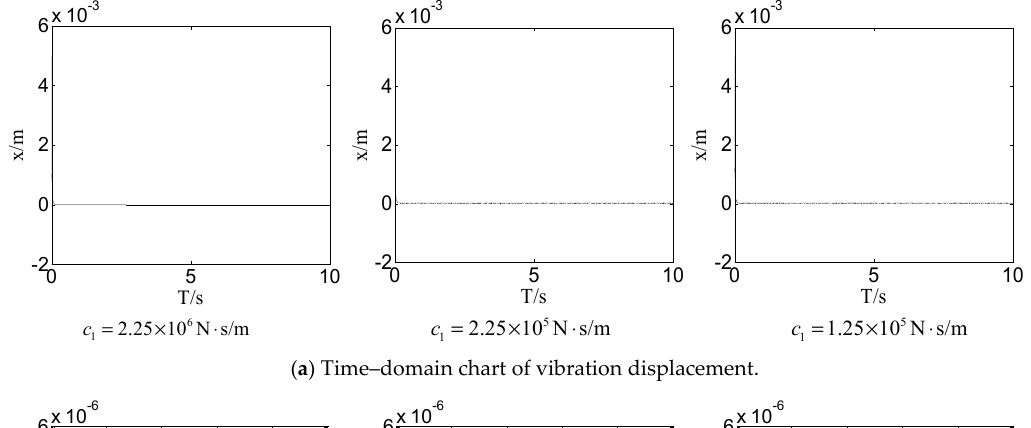
( a ) Time–domain chart of vibration displacement.